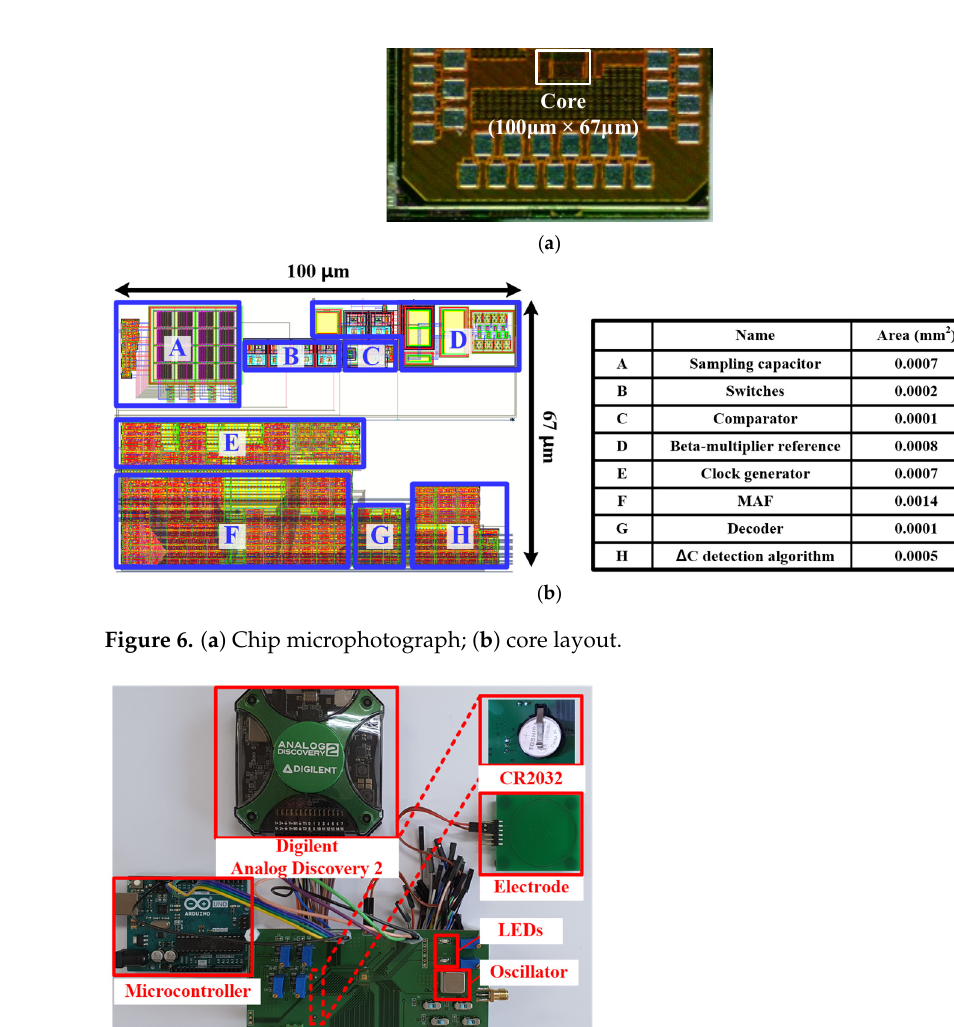
Figure 7. The chip measurement setup.